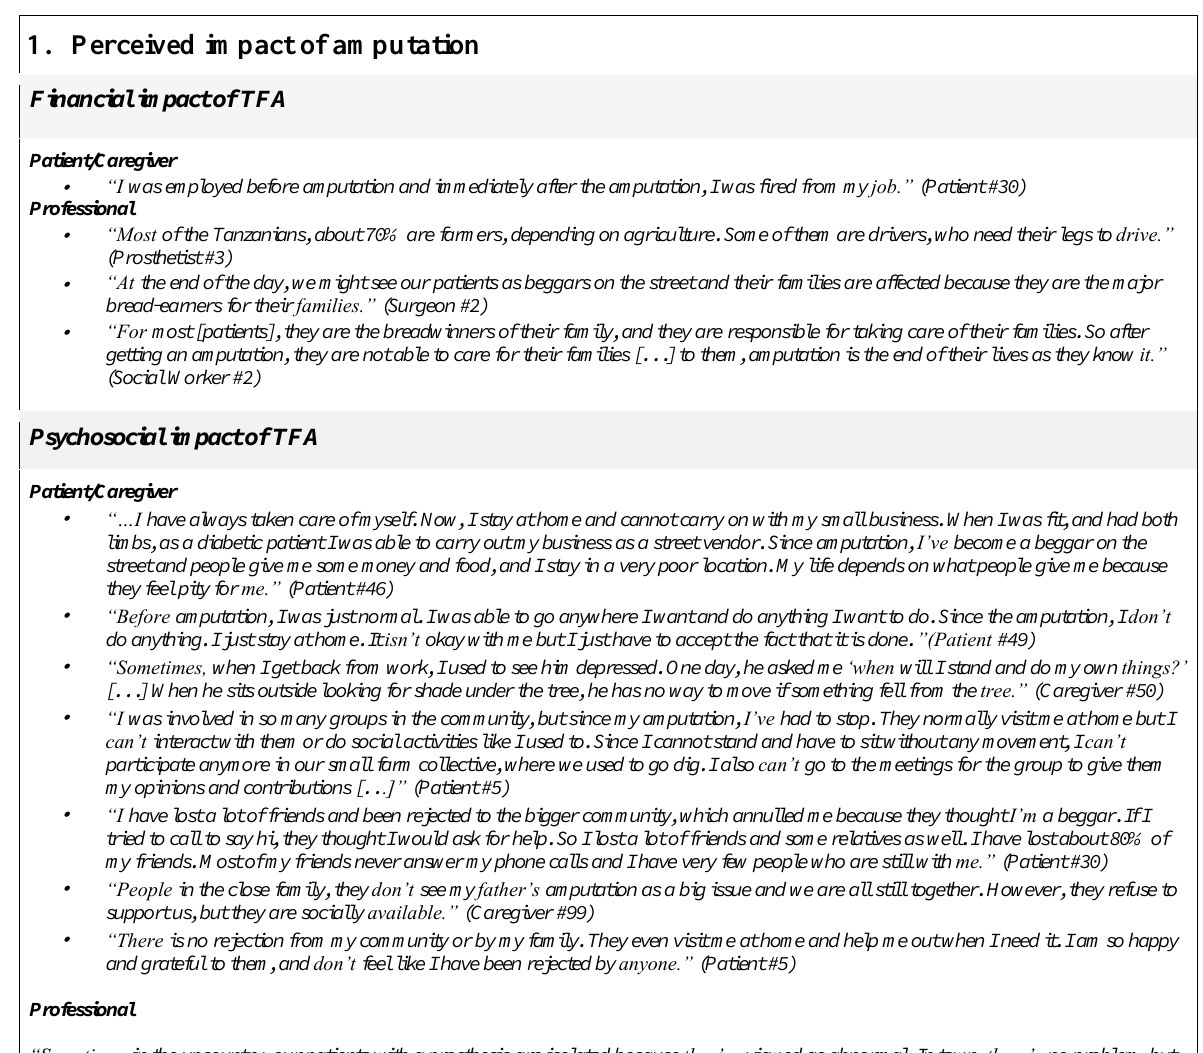
Table 1-A3: Thematic Analysis with supporting